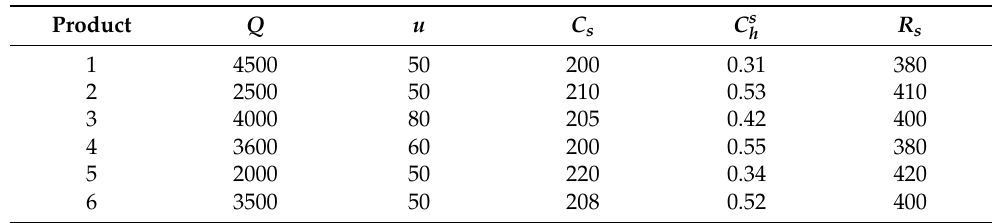
Table 1. Different parameter values of different products.